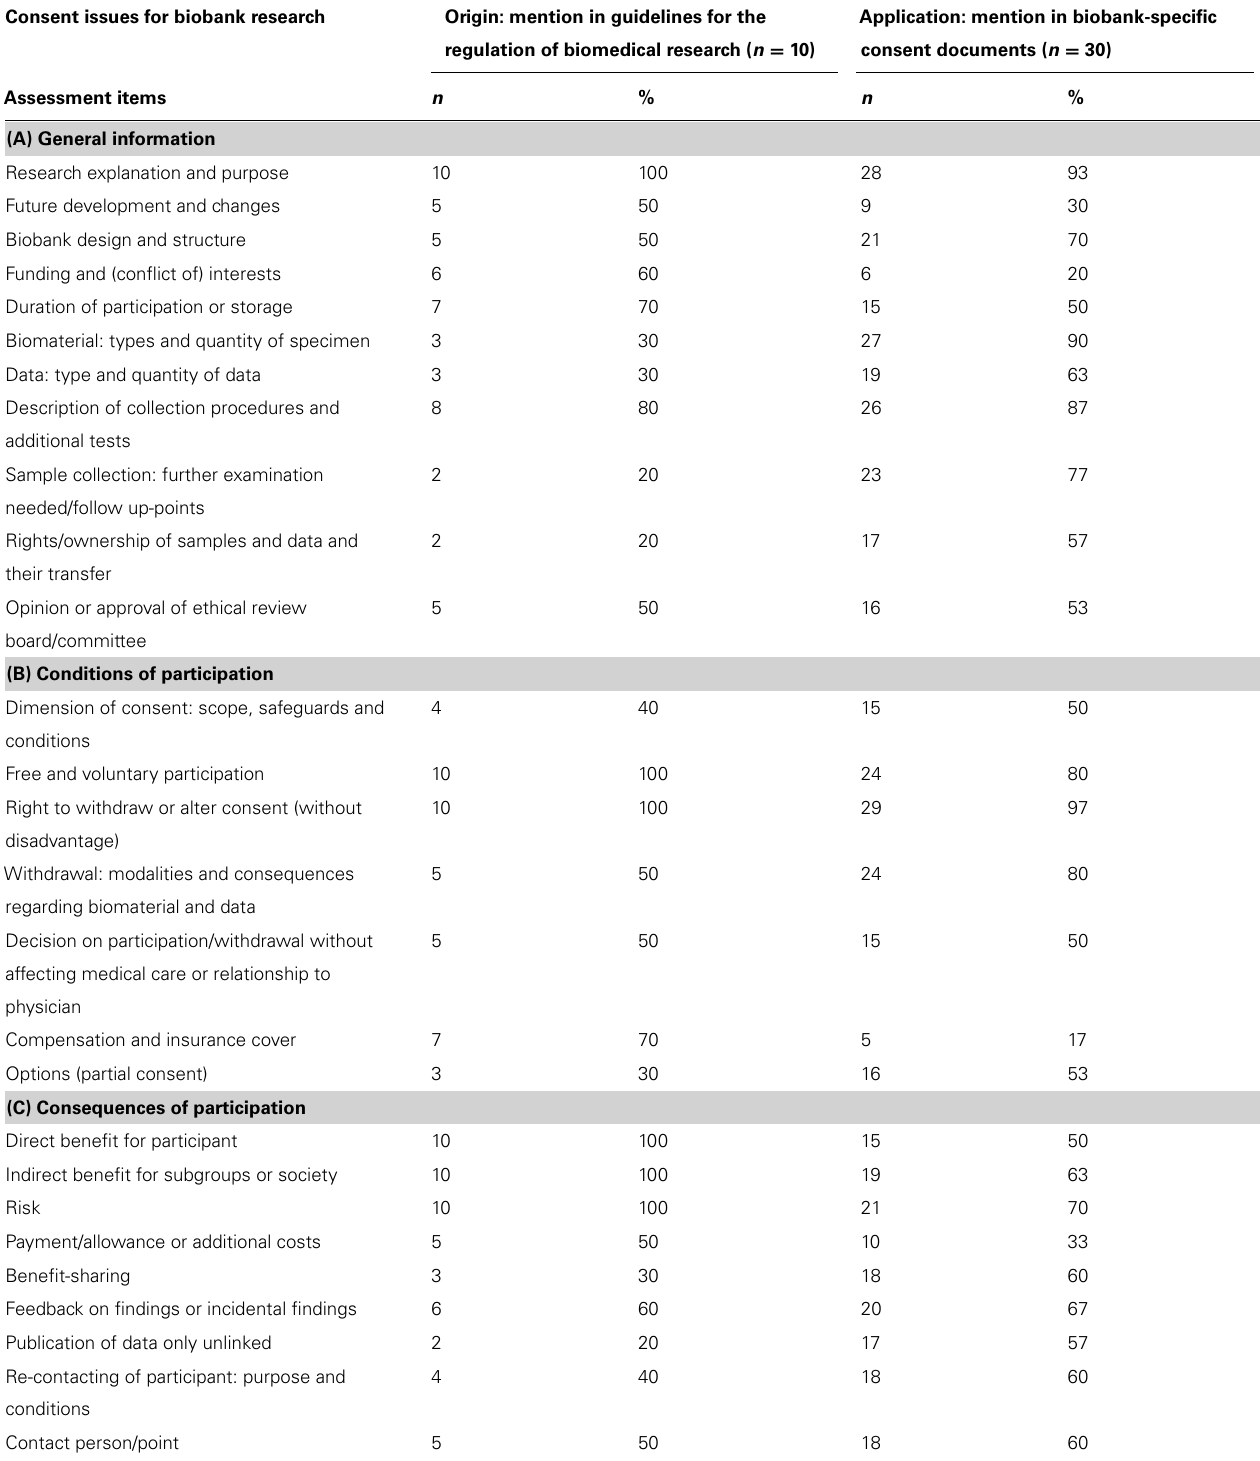
Table 1 | Representation of 41 consent issues for biobank research in 30 German consent